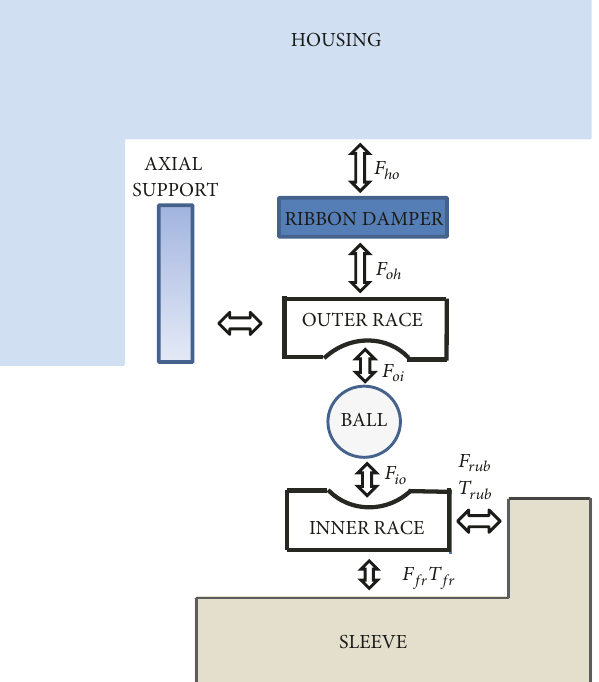
Figure 7: Schematic representation of the interactions between the elements of the auxiliary